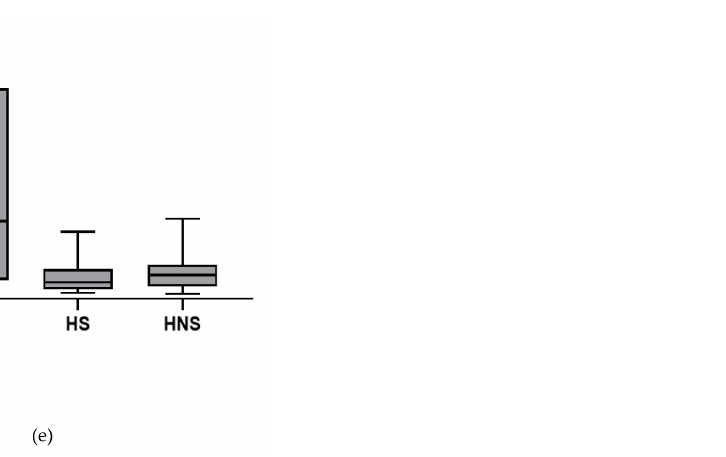
Figure 1. Sputum Biomarkers in chronic obstructive pulmonary disease (COPD) ( n = 30), healthy smokers (HS) ( n = 10) and healthy non-smokers (HNS) ( n = 10): ( a ) Interleukin (IL-)1 β , data is presented as minimum, maximum and median concentrations, data analysed using Krushkal-Wallis test with Dunns post hoc test. * p ≤ 0.05. ( b ) IL-6, data is presented as minimum, maximum and median concentrations, data analysed using Krushkal-Wallis test with Dunns post hoc test. * p < 0.05, ** p < 0.01. ( c ) Tumour necrosis factor (TNF)- α , data is presented as minimum, maximum and median concentrations, data analysed using Krushkal-Wallis test with Dunns post hoc test. * p < 0.05, ** p < 0.01. ( d ) IL-8, data is presented as minimum, maximum and median concentra- tions, data analysed using Krushkal-Wallis test with Dunns post hoc test. * p < 0.05, ** p < 0.01. ( e ) Myeloperoxidase (MPO), data is presented as minimum, maximum and median concentrations, data analysed using Krushkal-Wallis test with Dunns post hoc test.